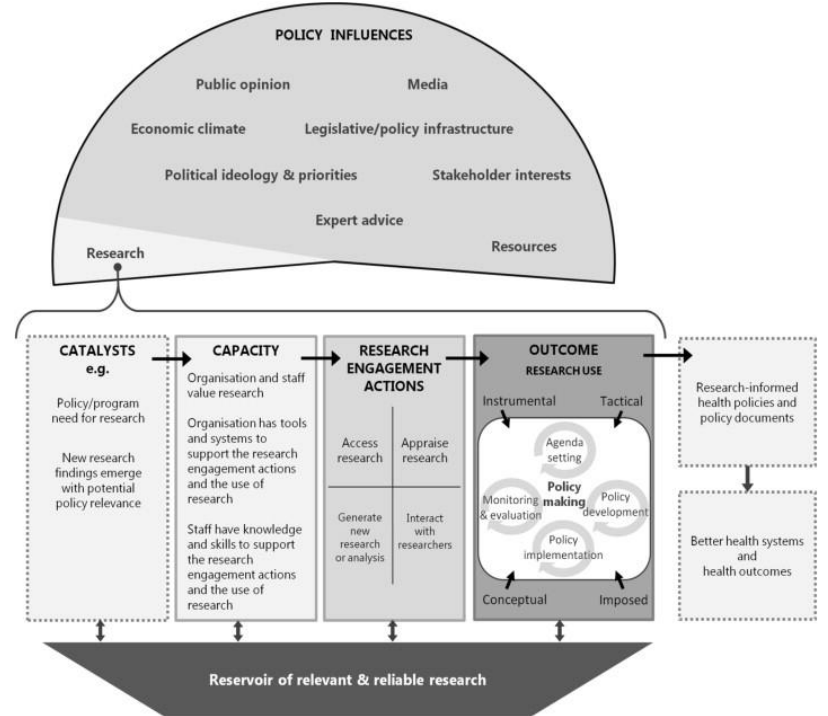
Figure 1. The SPIRIT Action Framework (Reprinted from The SPIRIT Action Framework: A struc- tured approach to selecting and testing strategies to increase the use of research in policy. Soc Sci Med, (2015), 136–137, 147–155. Redman, S., Turner, T., Davies, H., Williamson, A., Haynes, A., Brennan, S., Green, S. Copyright (2021), with permission of Elsevier).